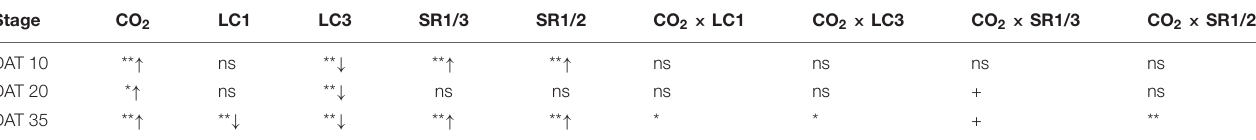
LC1, cutting off the flag leaf; LC3, cutting off top three leaves; SR1/3, removing one branch in every three branches of a panicle; SR1/2, removing one branch in every two branches of a panicle. DAT, day after source-sink treatment. **P < 0.01, *P < 0.05, + P < 0.1; ns, not significant; n = 3. Arrows in the treatment column indicate treatment increased ( ↑ ) or decreased ( ↓ ) the values.